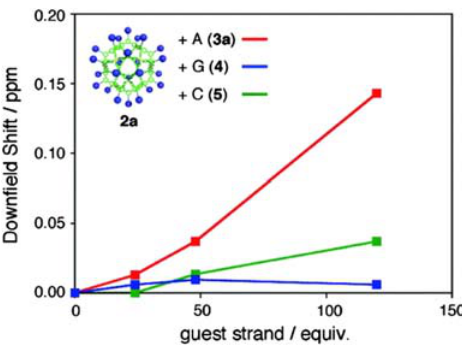
Figure 8. The values of downfield shift of thymine proton signals of 2a after the addition of mono-A (3a), G (4), C(5) (red line: 2a þ 3a; blue line: 2a þ 4; green line: 2a þ 5) ([2] ¼ 0.167mM, DMSO- d 6/CDCl3 ¼ 1:4, 500MHz, 300K). Reprinted with permission from (T. Kikuchi; S. Sato; M. Fujita. J. Am. Chem. Soc. 2010, 132 , 15930– 15932). Copyright (2010) American Chemical